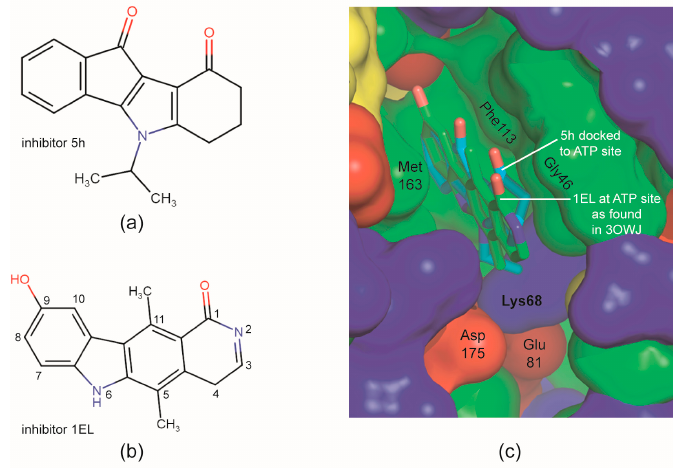
Figure 4. In silico structure modelling of CK2 α complexes with indeno[1,2- b ]indole-type CK2 inhibitors according to Alchab et al. [58]. ( a ) 5-Isopropyl-5,6,7,8-tetrahydroindeno[1,2- b ]indole-9,10-dione ( 5h ), one of four indeno[1,2- b ]indole-based inhibitors modelled into the ATP-site of CK2 α by Alchab et al. [58]. ( b ) The pyridocarbazolone-type CK2 inhibitor 1EL that was co-crystallized with CK2 α to give the complex structure 3OWJ [66] which served as a template for modelling of the CK2 α / 5h complex by Alchab et al. [58]. ( c ) Overlay of the X-ray structure of the CK2 α complex with 1EL (green C-atoms; PDB 3OWJ) and the in-silico model of the CK2 α complex of 5h (light blue C-atoms). Modified version of a picture originally published by Alchab et al. [58] with kind permission of MDPI AG, Basel, Switzerland.